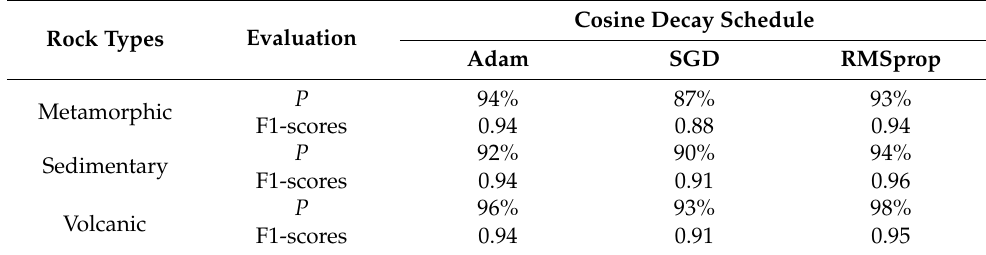
Table 6. Detailed classification results for all rock types.